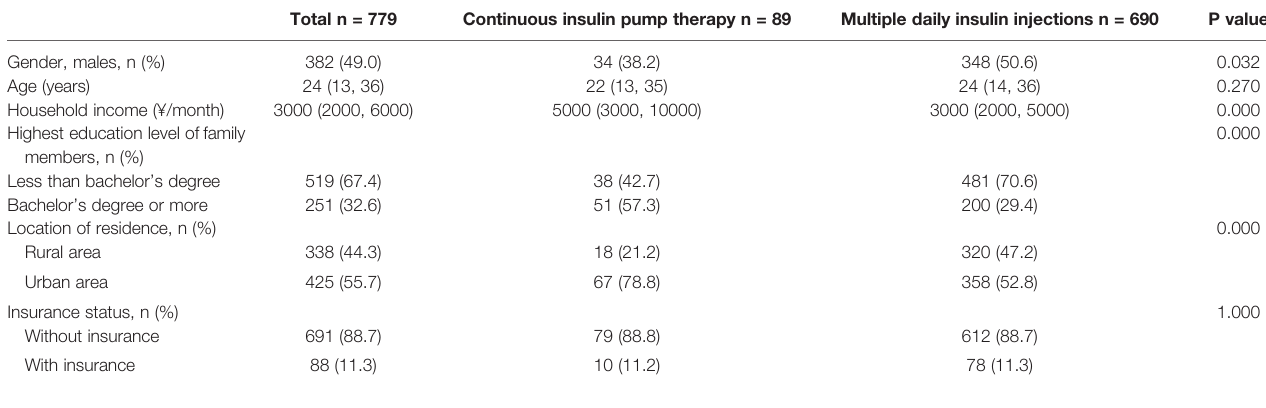
TABLE 1 | Demographic characteristics of people with type 1 diabetes by insulin